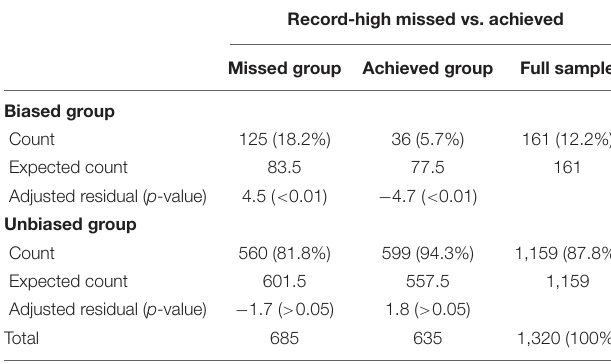
TABLE 4 | Results of chi-square